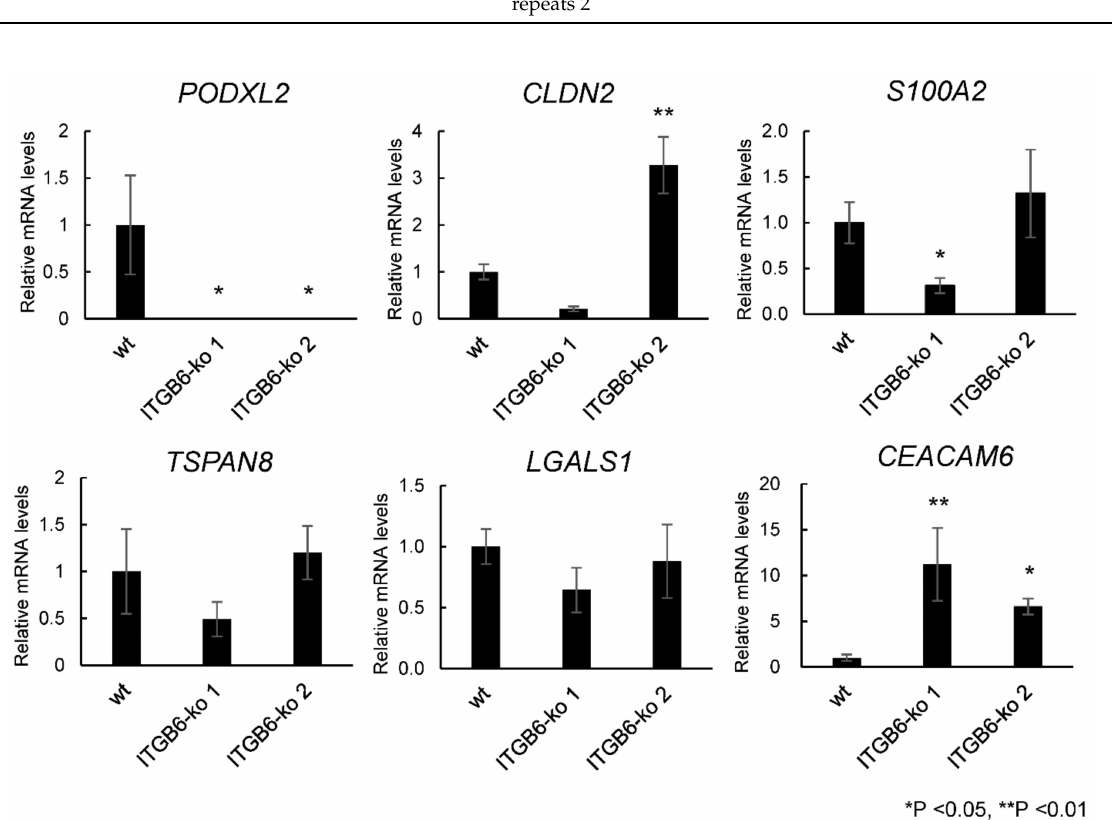
Figure 4. Real-time polymerase chain reaction analysis. mRNA levels of podocalyxin-like 2 ( PODXL2 ) were significantly decreased concordantly in both integrin β 6-knockout (ko) 1 and -ko 2 cells compared with HuCCT1 wild-type cells, whereas CEA cell adhesion molecule 6 ( CEACAM6 ) mRNA levels were increased concordantly. The mRNA level of claudin 2 was significantly increased in ITGB6 -ko 2 cells, and S100 calcium-binding protein A2 mRNA level was significantly decreased in ITGB6 -ko 1 while tetraspanin 8 and galectin 1 showed no significant change. All experiments were performed in